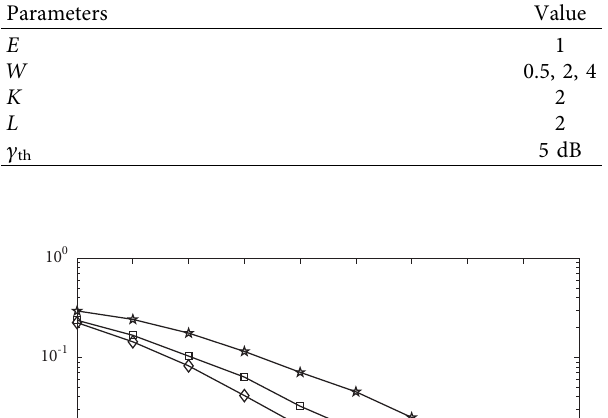
Figure 3: The ASEP performance with different ( W ) .